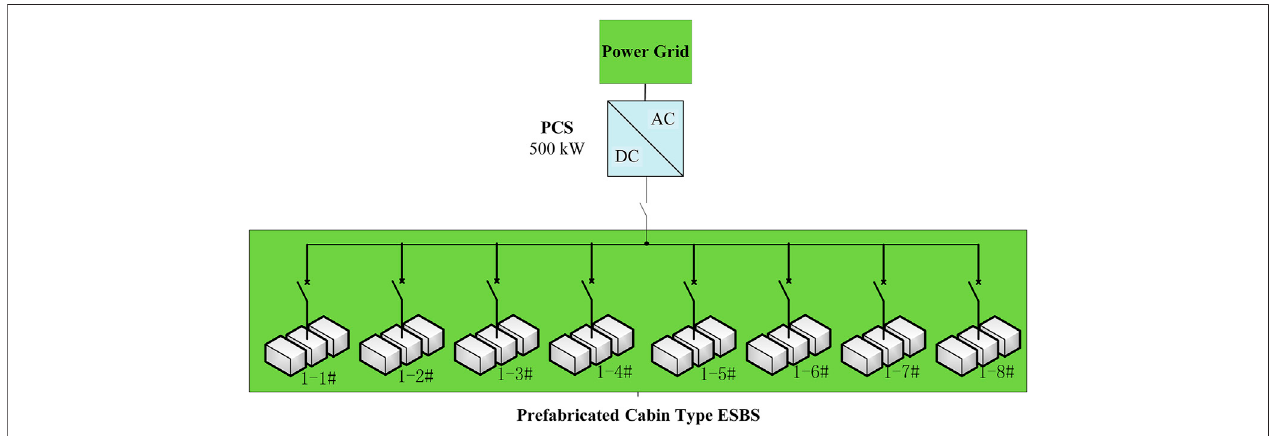
FIGURE 1 | Common structure of cabin-type energy storage